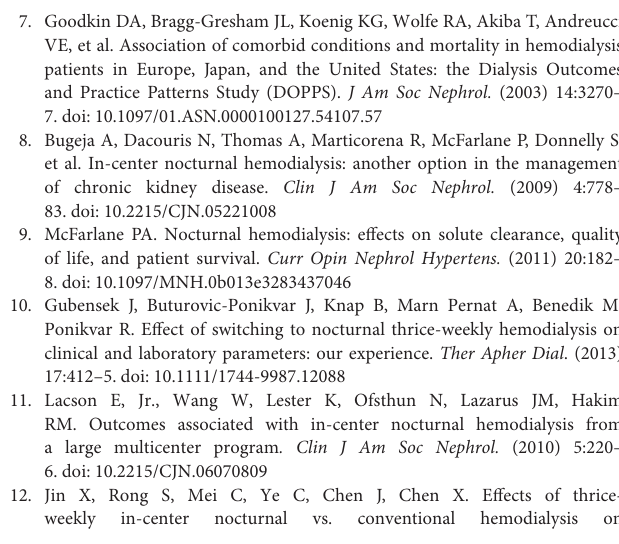
Supplementary Table S1 | Baseline biochemical parameters of patients undergoing